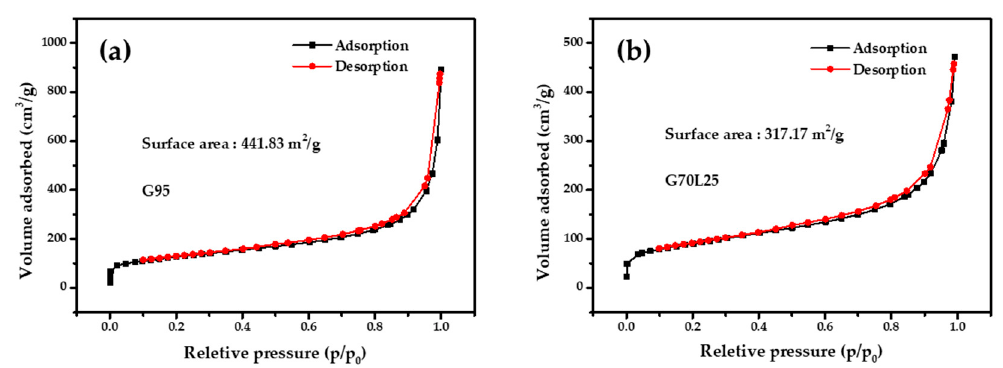
Figure 3. Nitrogen adsorption and desorption isotherms for ( a ) G95 and ( b ) G70L25.